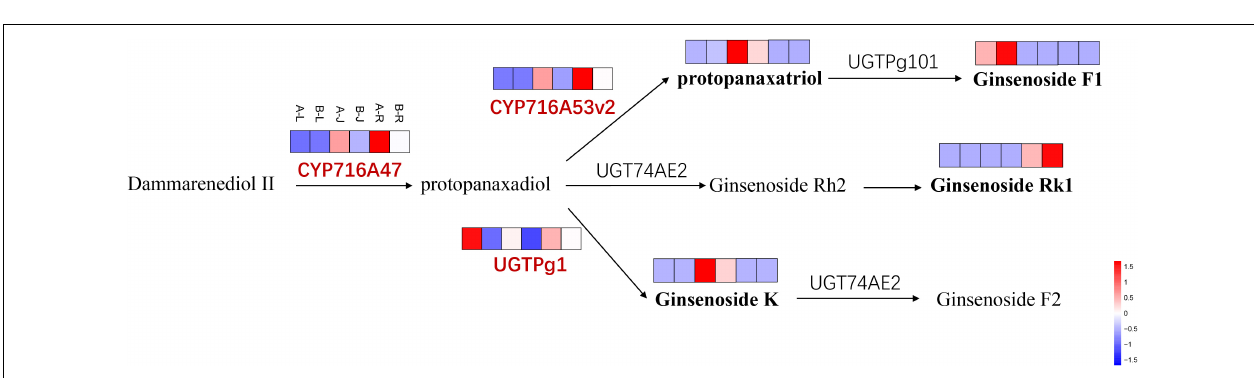
FIGURE 9 | Quadrant diagram representing the association of transcriptomics and metabolomics variations in A-J vs. B-J (A) , A-L vs. B-L (B) , and A-R vs. B-R (C) . The black dotted lines represent the differential thresholds. Outside the threshold lines, there are significant differences in the gene/metabolites, whereas within the threshold lines the gene/metabolites are unchanged. Each point represents a gene/metabolite. Black dots = unchanged genes/metabolites, green dots = differentially accumulated metabolites with unchanged genes, red dots = differentially expressed genes with unchanged metabolites, and blue dots = both differentially expressed genes and differentially accumulated metabolites.